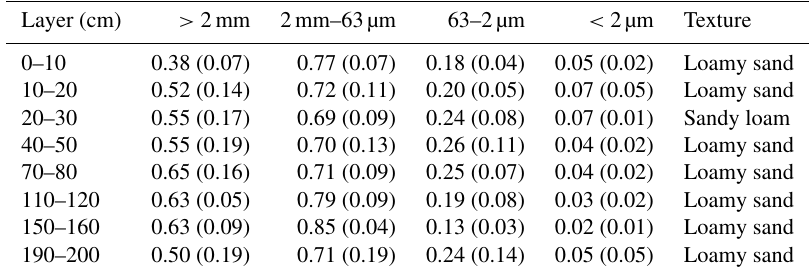
Table 2. The particle size diameter fractions (for > 2mm this is the mass ratio between soil particles greater than 2mm and total soil sample, while for the other fractions this is the ratio between mass of the soil in the size range and the mass of all particles < 2mm) and soil texture (based on USDA classification) of different layers based on soil samples in this study.